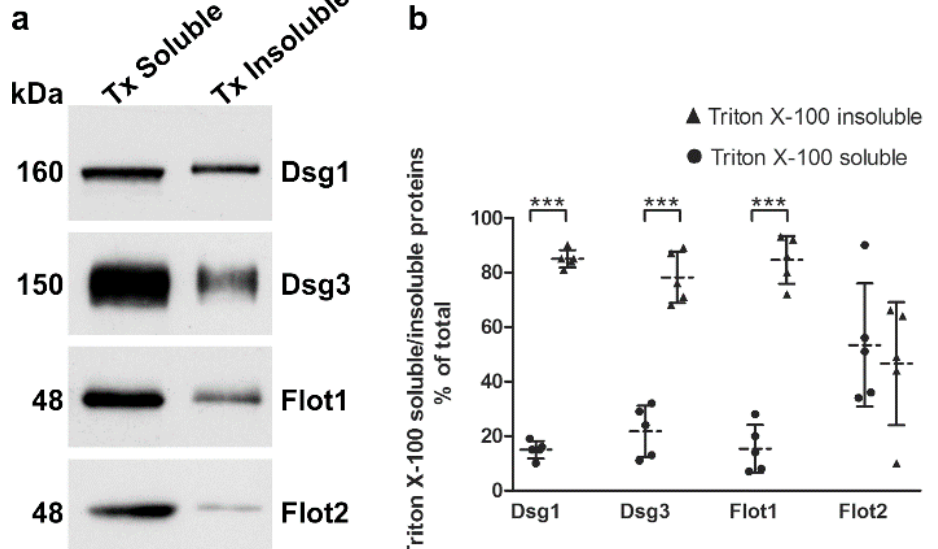
Figure 6. Detergent solubility of desmogleins and flotillins in hTert cells. The cells were grown in KGM with 2 mM calcium for 24 h and a sequential detergent extraction was performed, resulting in two pools with detergent soluble and insoluble proteins. ( a ) Western blot analysis of these fractions was used to detect Dsg1, Dsg3, Flot1 and Flot2; ( b ) quantification of the gel bands was performed with the Quantity-One software, and the percentage of the total cellular protein was calculated taking into account that triton X-100 (TX) soluble bands represent a higher relative percentage of the respective fraction than the TX insoluble bands. For statistical analysis, unpaired Student’s t -test was used. Statistically significant differences are indicated by *** p < 0.001. n = 5 independent experiments. Dotted line: Mean of samples, solid lines: SD.